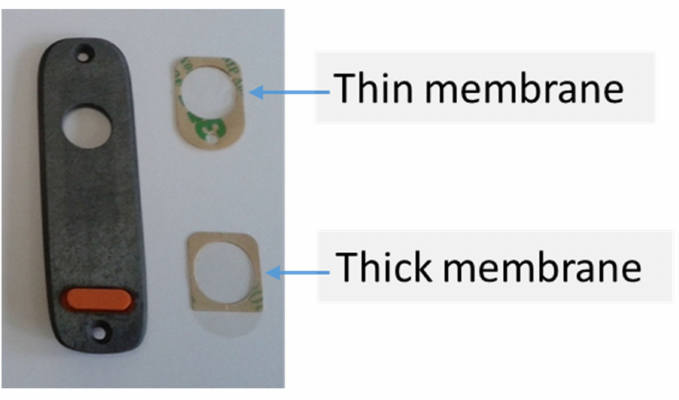
Figure 4. Front part of a Niton Xl3t spectrometer, and